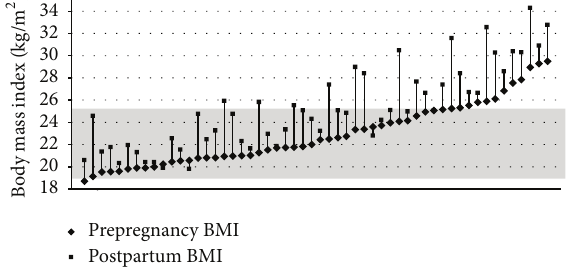
Figure 1: Comparison of Individual Mother’s Pre-Pregnancy with their Post-Partum BMI. The differences in the individual weight gains for our 54 mothers are described. The shaded box represents the normal BMI category (18.8–24.9 kg/m 2